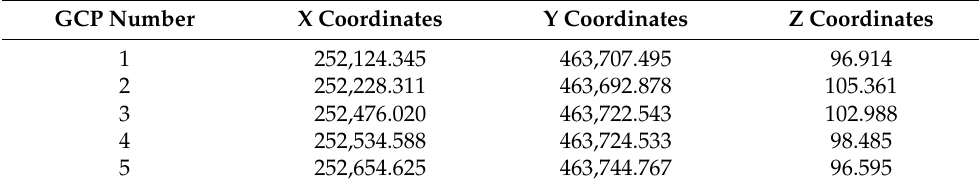
Table 2. GCPs coordinates of the case study area measured by GNSS